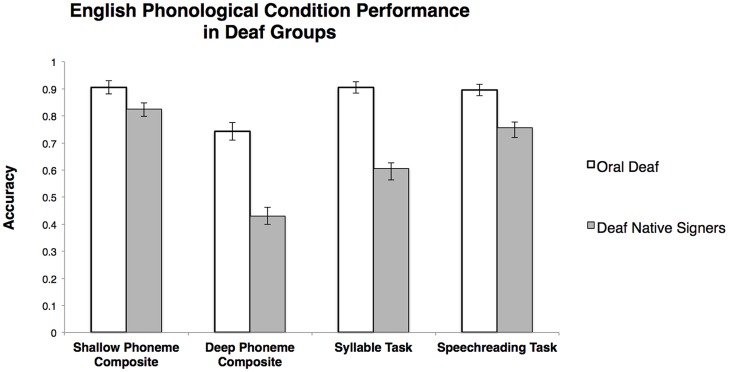
English Phonological Task Performance. Error bars represent the SE of the mean.